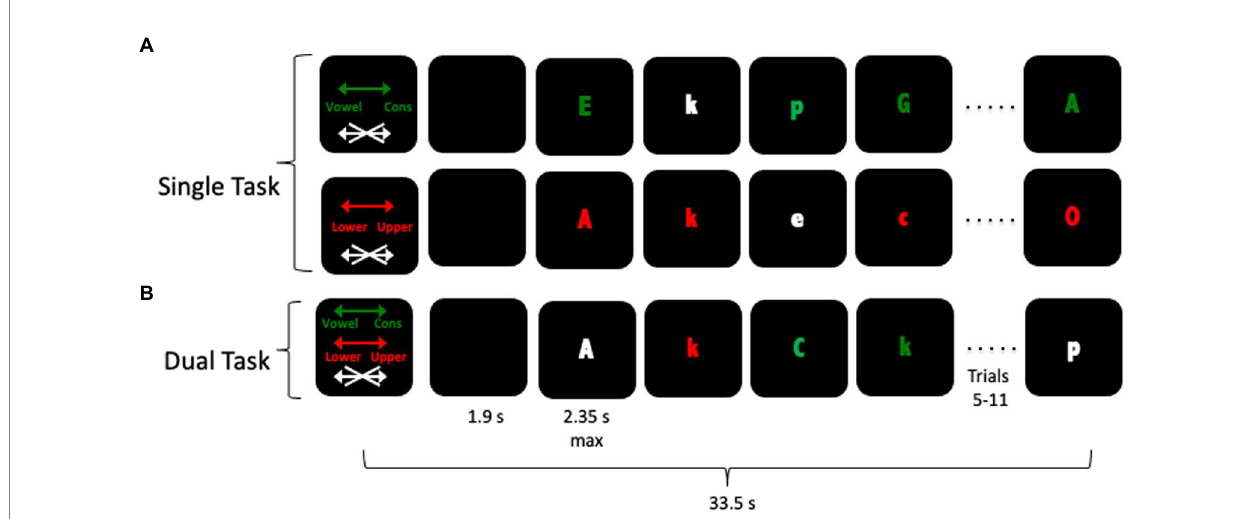
FIGURE 1 Schematic of the fMRI task. Participants received an instruction cue followed by 12 trials in which they used their left and right index fingers to indicate their response. The color of the letter indicated which task—Vowel/Consonant (green) or Upper/Lower (red) cased or NoGo (white)—should be performed. Panel (A) represents both types of single-task blocks, in which only one of the two tasks sets were cued. Panel (B) represents a dual-task block, in which participants alternated between the two different